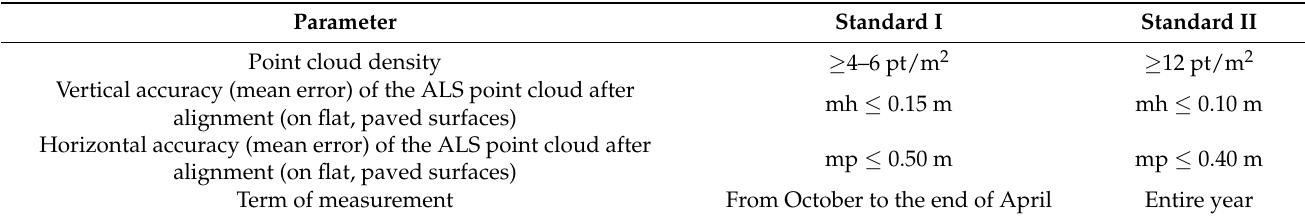
Table 1. Characteristics of the ISOK LiDAR products with regard to standards [21]. Parameter Standard I Standard II Point cloud density ≥ 4–6 pt/m 2 ≥ 12 pt/m 2 Vertical accuracy (mean error) of the ALS point cloud after mh ≤ 0.15 m mh ≤ 0.10 m alignment (on flat, paved surfaces) Horizontal accuracy (mean error) of the ALS point cloud after mp ≤ 0.50 m mp ≤ 0.40 m alignment (on flat, paved surfaces) Term of measurement From October to the end of April Entire